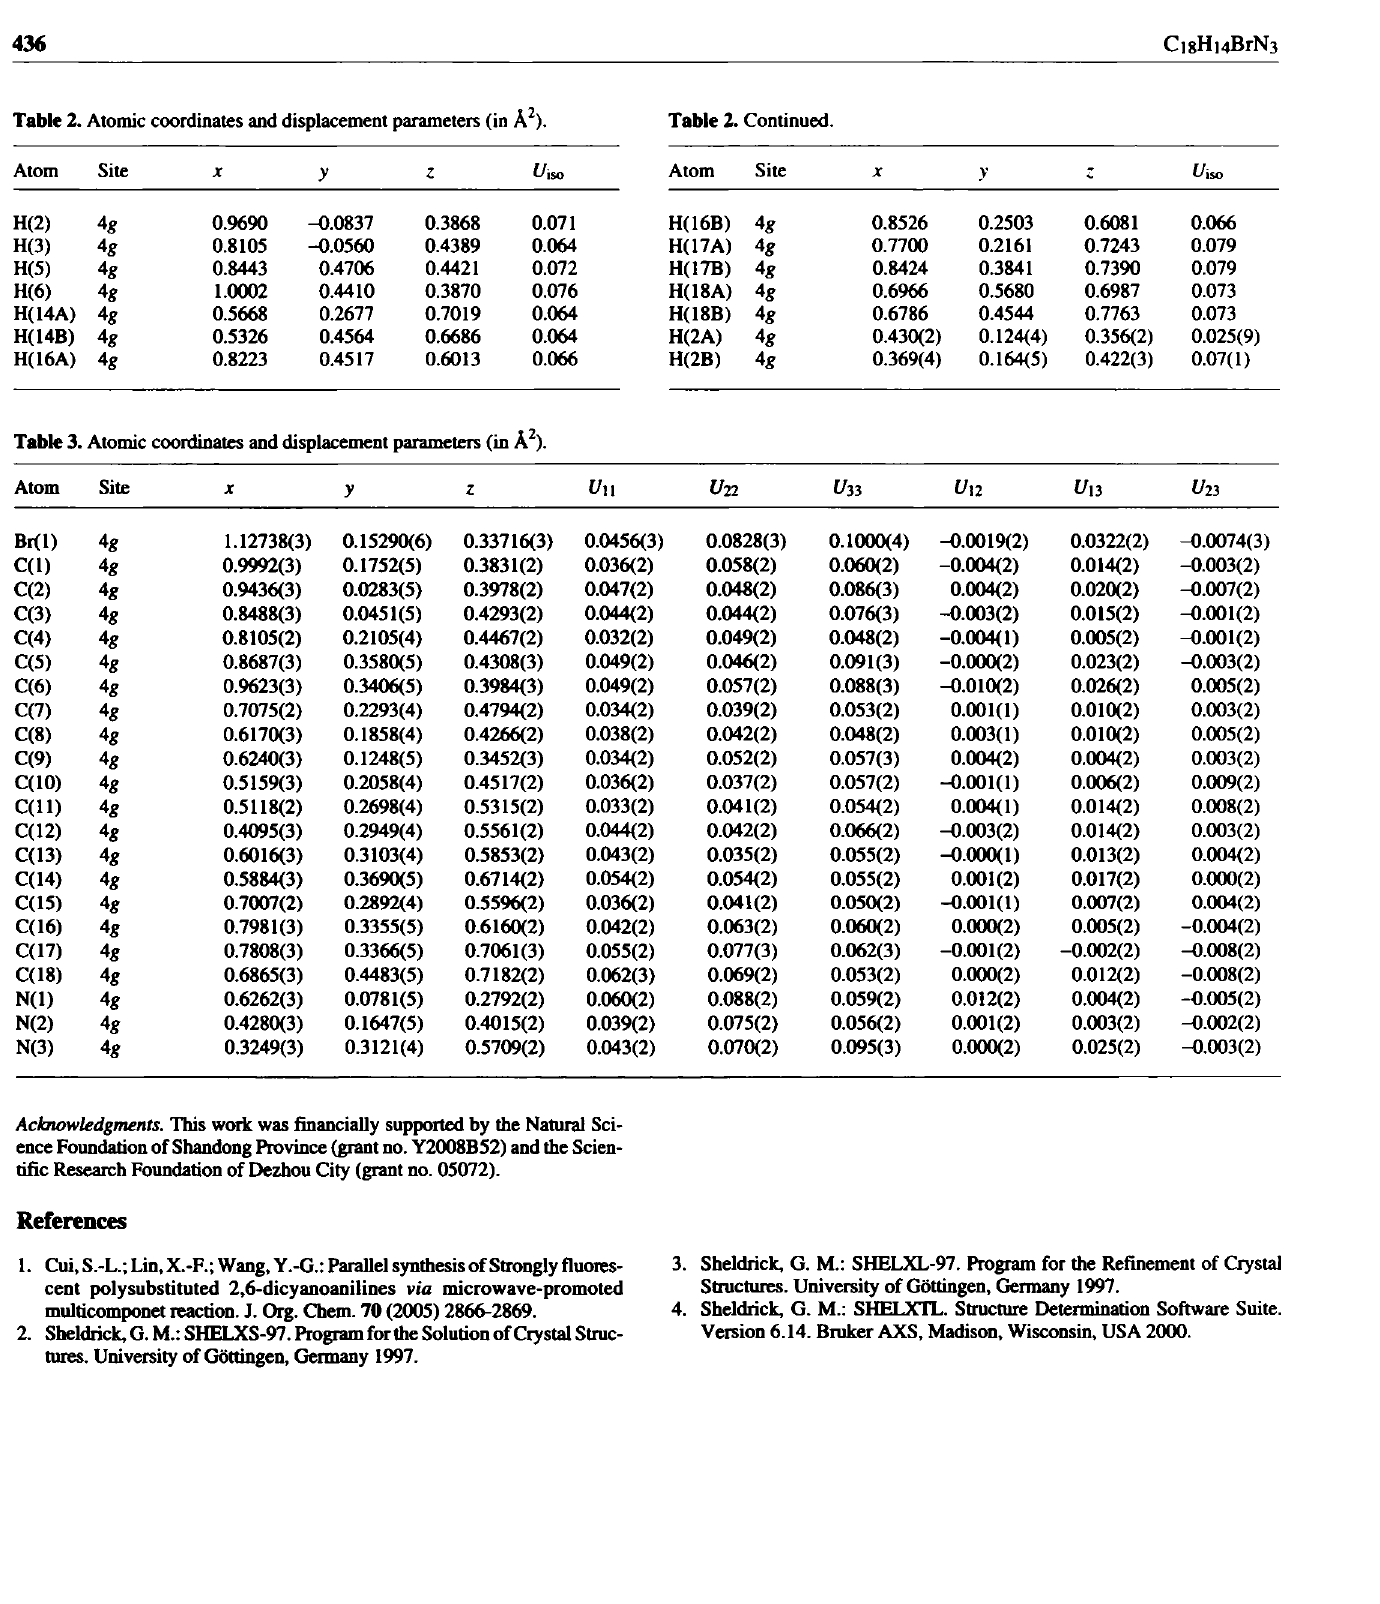
Table 3. Atomic coordinates and displacement parameters (in À 2